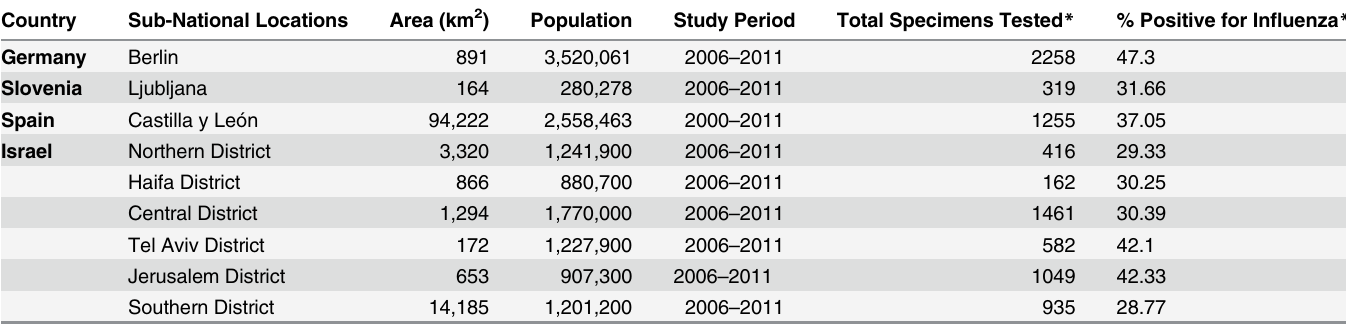
Table 1. Study locations and influenza data